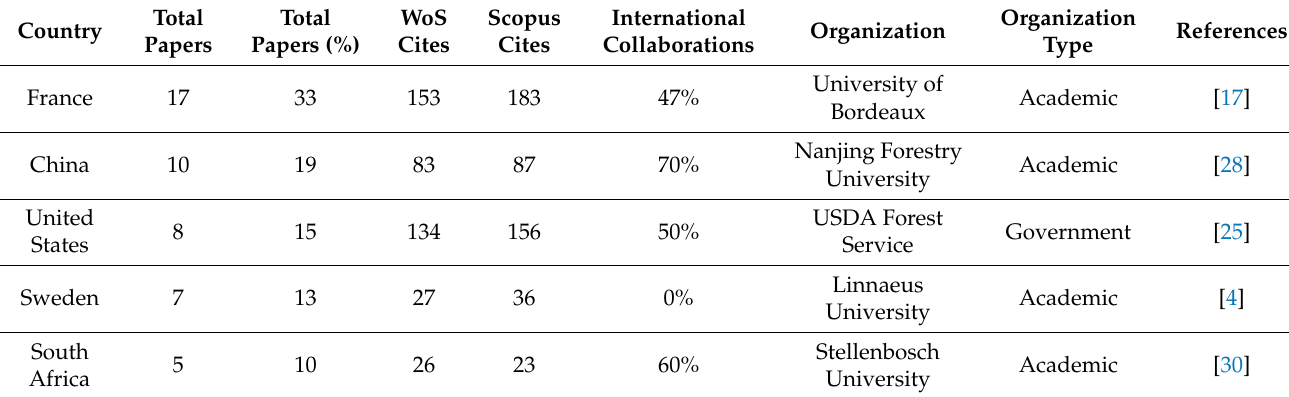
Table 2. Countries with the highest productivity in “Green